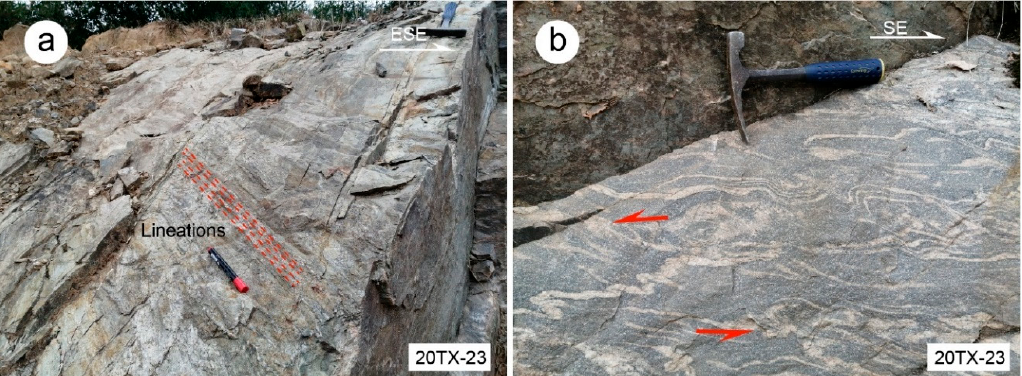
Figure 6. Outcrop photographs of structures in the SW domain of the Taoxi dome. ( a ) Mylonitized rock with SW-dipping foliations and NW–SE sub-horizontal stretching lineations. ( b ) Asymmetric intrafolial folds indicate sinistral sense of shear. The red arrows show the shear